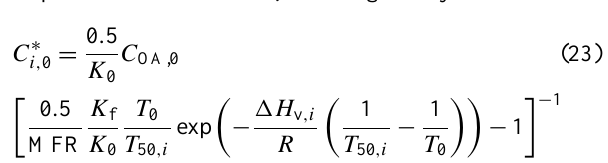
Fig. 10. Relationship between log P 25 and 1/ T 50 derived with Eq. (22) for the organic compounds used in the calibration by Faul- haber et al. (2009), in comparison with experimental data. The er- ror bars in the theoretical calculation denotes the uncertainty in the aerosol loading (100–200µgm − 3